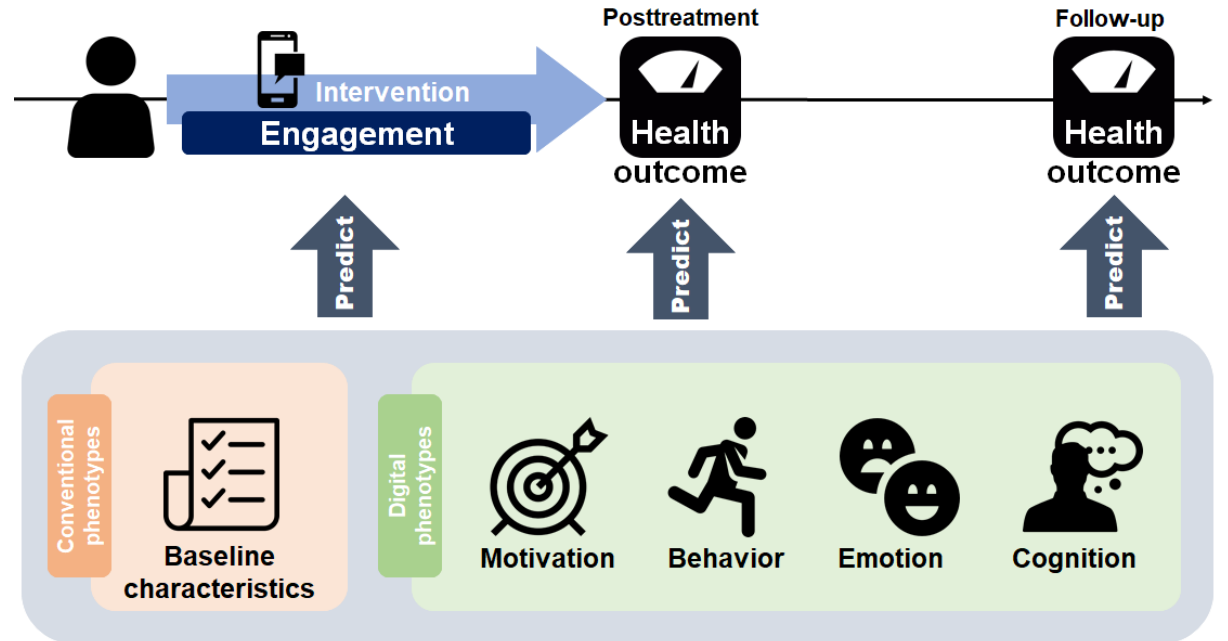
Figure 1. A conceptual framework of mobile health components and examples of digital